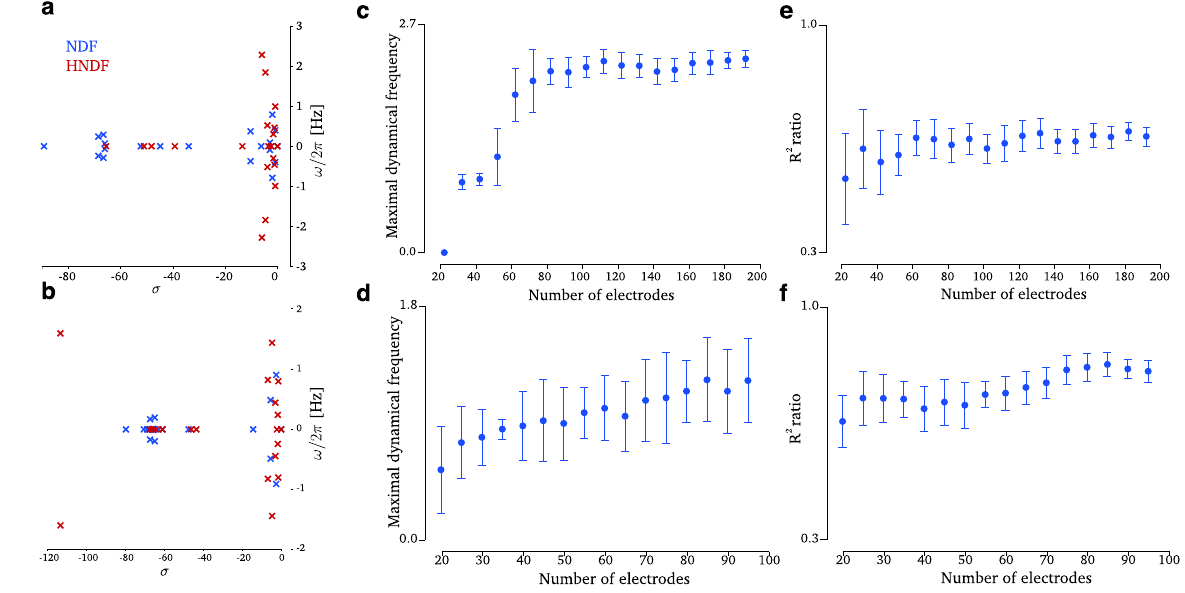
Figure 3. Eigenspectrum and rotational modes. ( a ) Eigenvalue spectrum of the remembered dynamics matrix used for decoder hysteresis (red) and an example eigenvalue spectrum of re-learned neural dynamics (blue) with the simulated loss of 140 electrodes in Monkey J. The frequencies used by the re-learned dynamics are smaller than those of the remembered dynamics. ( b ) Eigenvalue spectrum of the remembered dynamics matrix used for decoder hysteresis (red) and an example eigenvalue spectrum of re-learned neural dynamics (blue) with the simulated loss of 60 electrodes in Monkey L. ( c ) The max frequency of the dynamical system versus the number of electrodes used to infer the dynamics in Monkey J. We only considered oscillation frequencies for modes which had a time constant of decay greater than 20 ms, since the timescale of the exponential decay would be faster than any oscillation. The oscillation frequencies of the neural dynamics decrease as the number of electrodes decreases (linear regression r 2 = 0.59, slope significantly different than 0 at p < 0.01). This trend also held up using the average frequency of the eigenvalues of the dynamical system. ( d ) Same as ( c ) but for Monkey L (linear regression r 2 = 0.48, slope significantly different than 0 at p < 0.01). ( e ) The R 2 ratio quantifies the ratio in describing the neural population activity with a skew symmetric dynamics matrix (having purely imaginary eigenvalues) vs the least-squares optimal dynamics matrix (having complex eigenvalues) as further described in the Methods. If the R 2 ratio is large, it signifies that much of the dynamical variance can be captured by a purely rotational dynamics matrix. As electrodes are lost in Monkey J, the R 2 ratio significantly declines (linear regression r 2 = 0.13, slope significantly different than 0 at p < 0.01), indicating that the neural activity is less well-described by rotational modes. ( f ) Same as ( e ) but for Monkey L (linear regression r 2 = 0.43, slope significantly different than 0 at p <